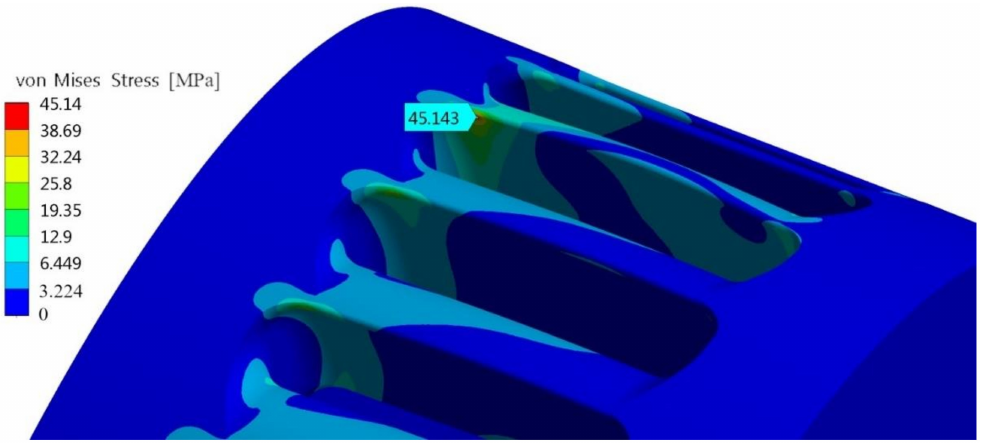
Figure 18. von Mises stress for proposed impeller.